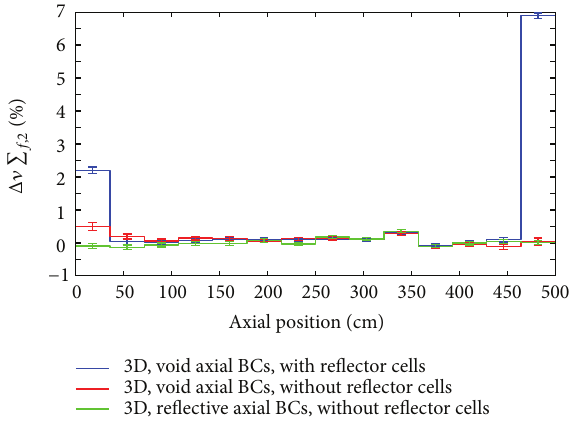
Figure 16: Relative differences between fission neutron production cross sections for the thermal